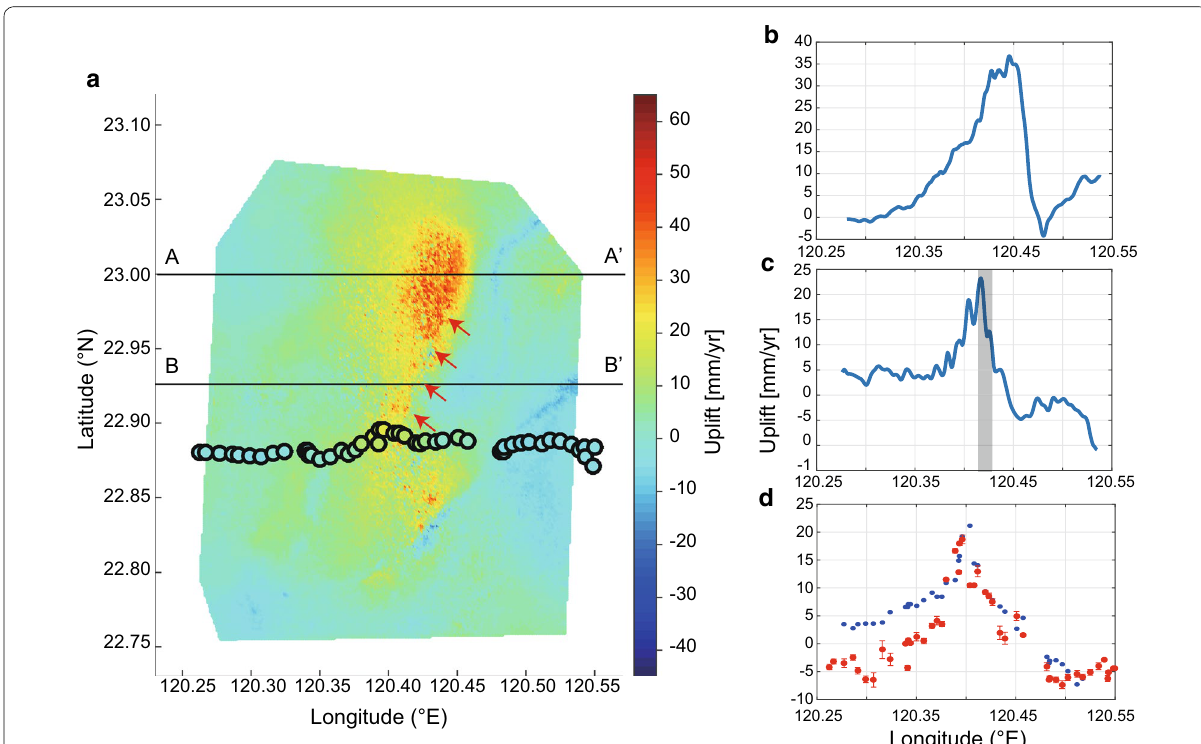
Fig. 3 Uplift rate calculated from 2.5-dimensional analysis using ALOS data. a Distribution of uplift rate. Colored circle stands for the uplift rate obtained from leveling survey (Ching et al. 2016). Sharp discontinuity in the uplift rate is marked by red arrows. b Uplift rate along the profile A–A ′ . c Uplift rate along the profile B–B ′ . Sharp discontinuity in the uplift rate is marked by a shading as well as in Fig. 4c. d Uplift rate measured by InSAR (blue dot) and leveling survey (red dot). We took 5-point running mean for the uplift rates given by InSAR in ( b ) and ( c